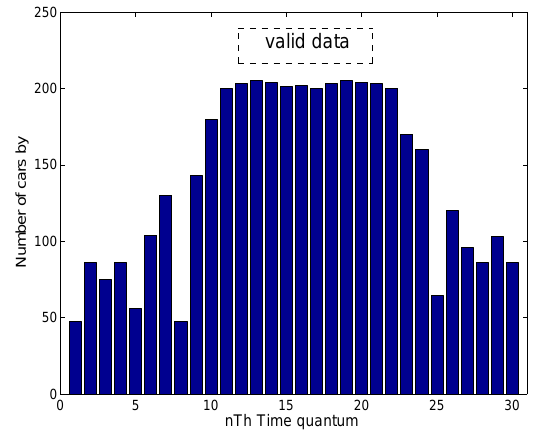
Figure 3. Determine valid data operation.